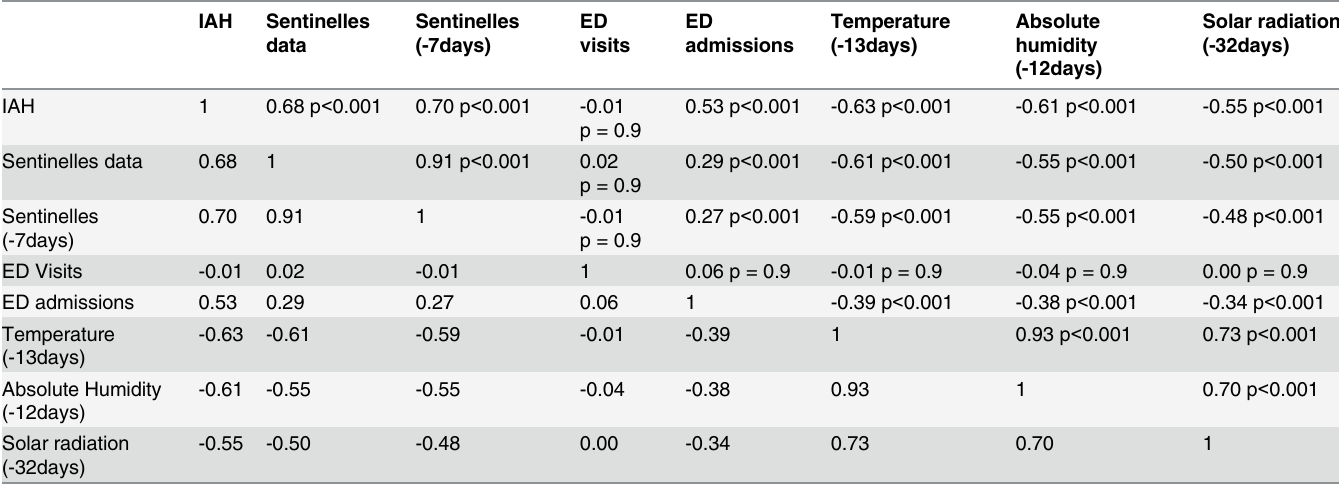
Table 3. Correlation matrix (delays in parentheses when